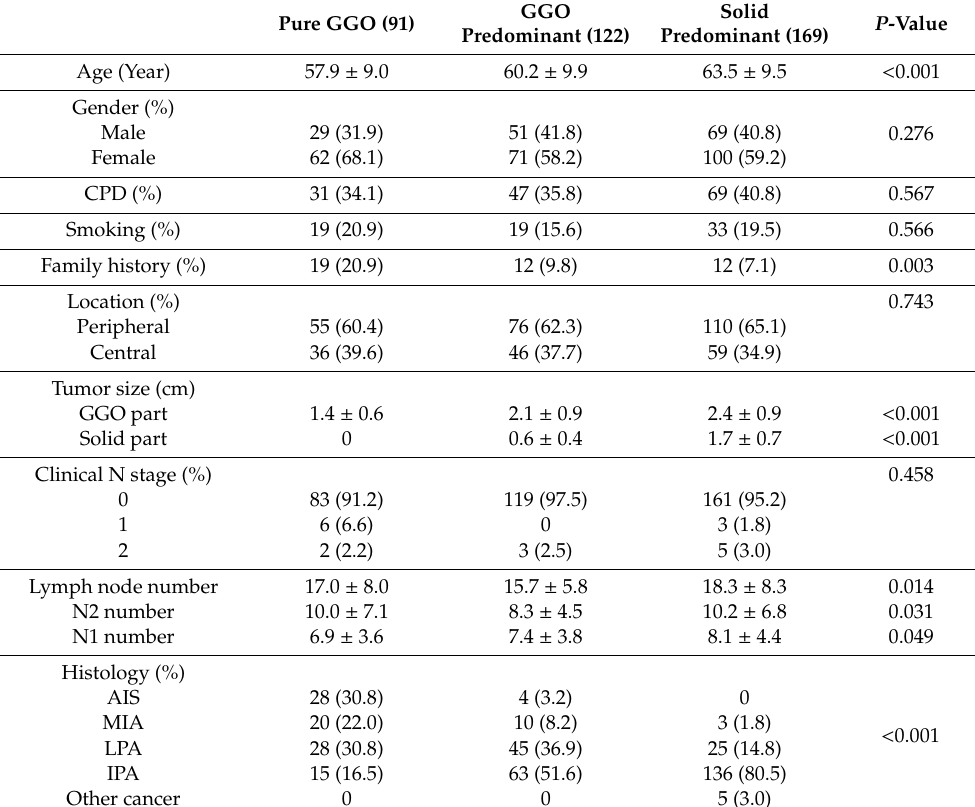
Table 2. Demographics for patients receiving lobectomy or bilobectomy for small nodules with a GGO